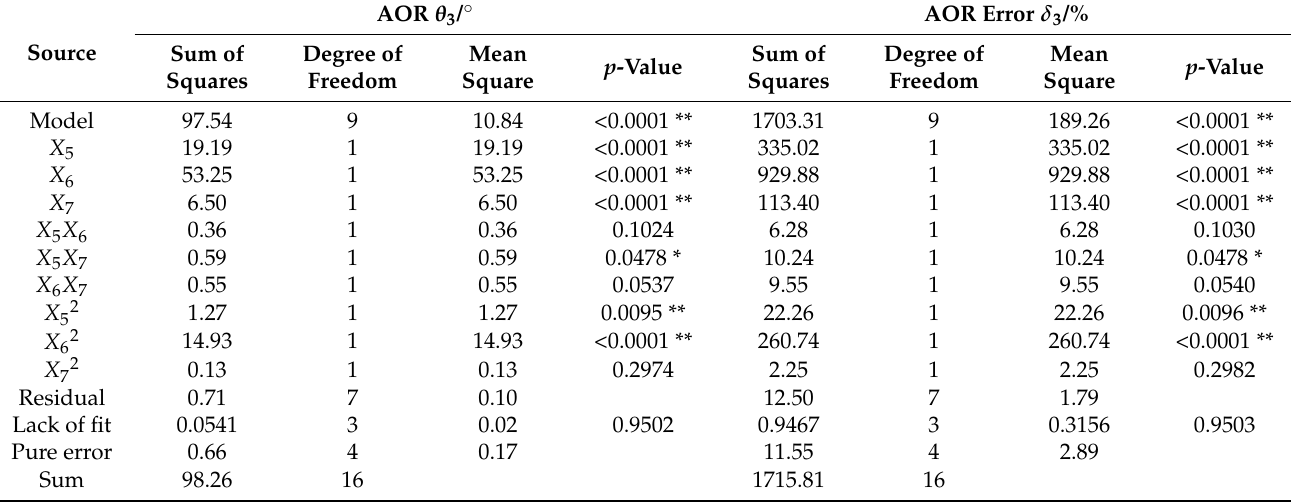
Table 7. ANOVA of Box–Behnken